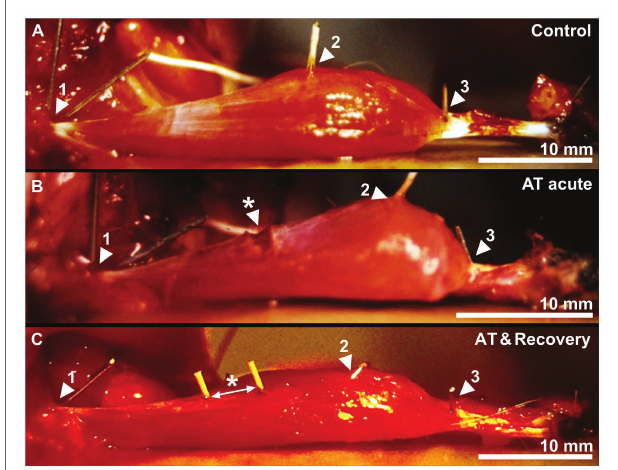
FIGURE 2 | A control, acutely aponeurotomized and a recovered muscle after aponeurotomy. (A) Active muscle near optimum length of a control GM muscle. (B) The effects of acute aponeurotomy on the muscle. The fibers of the aponeurosis were transsected, creating a gap on the medial aponeurosis. (C) Active muscle near optimum length of a recovered GM muscle. Markers 1, 2, and 3 represent the origin of the muscle, the distal end of the proximal aponeurosis, and the distal end of the distal muscle fiber, respectively. The white arrow indicates the space between the markers, which were placed at the location of the sutures. * indicates the newly formed connective tissue, closing the aponeurotic